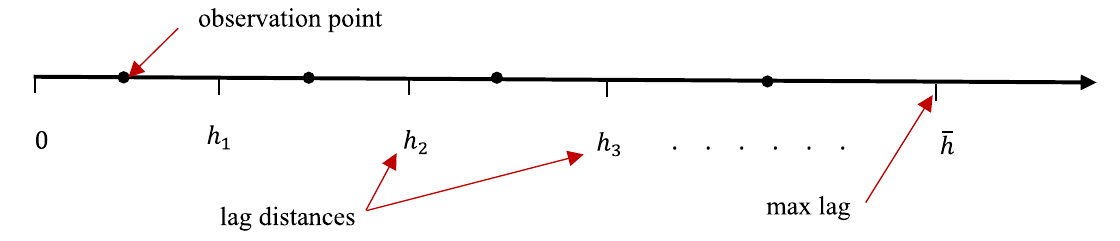
Fig. 2 Component of an experimental semivariogram based on observation data